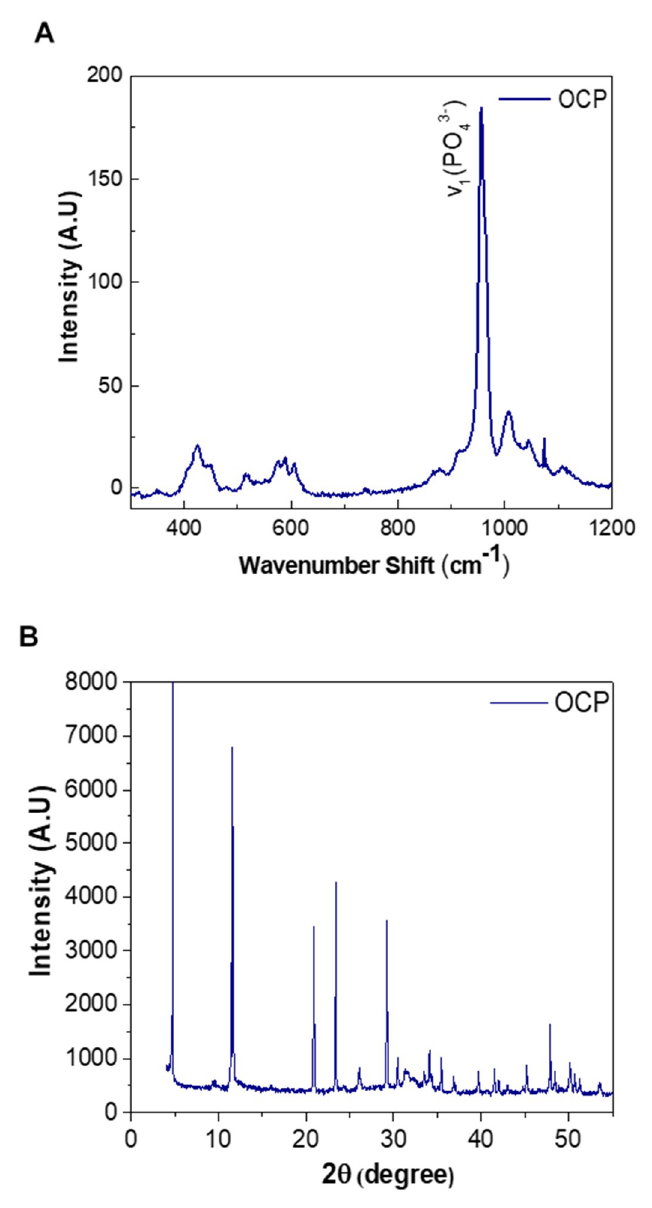
Figure 3. Phase and chemical properties of OCP by XRD and Raman spectra. ( A ) Raman spectra of OCP. ( B ) XRD pattern of OCP.